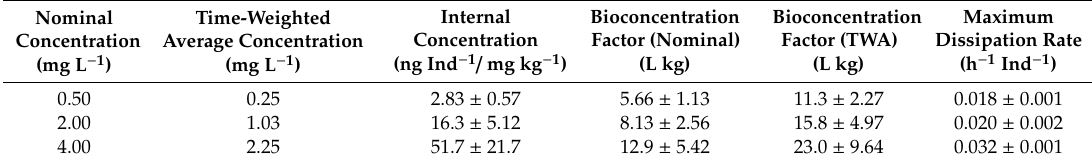
Table 1. Nominal exposure concentrations, time-weighted average (TWA) exposure concentrations based on the area-under-the-curve (AUC) approach, measured internal concentrations in larvae 120 hpf (as larvae of that age weighed 1 mg wet weight, levels in ng Ind − 1 translate directly into mg kg − 1 ), as well as bioconcentration factors based on nominal and TWA concentrations, and dissipation rates from exposure vessels ( n = 2 independent